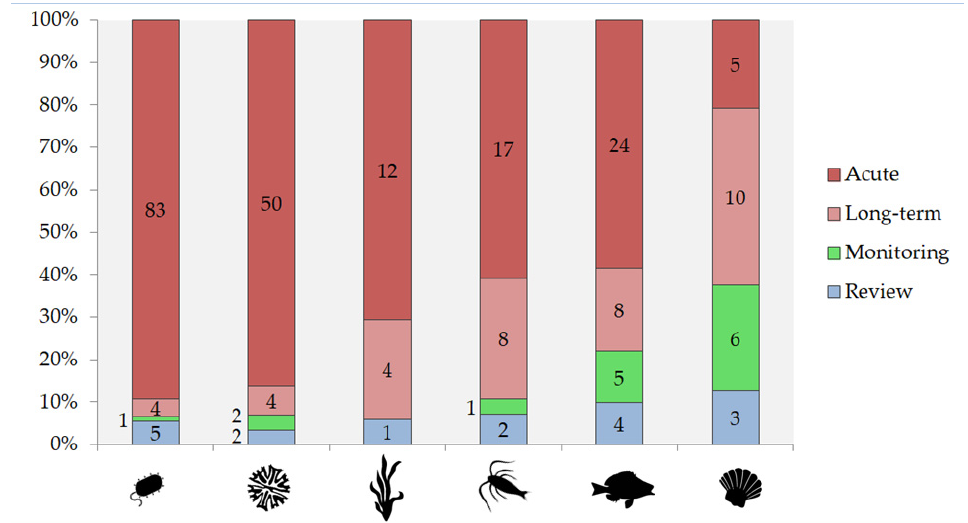
Figure 3. Share of publications on ecotoxicity of Ln based on exposure time: (i) only acute (<14 days) toxicity data, (ii) studies including long-term ( ≥ 14 days) experiments, (iii) monitoring studies where data were collected from natural populations, and (iv) reviews. The publications are given separately for different organism groups (see Table 1) from left to right: microorganims, phytoplankton, macrophytes, zooplankton, nekton, and benthos. The number of papers within each category is given inside or left to the respective column.